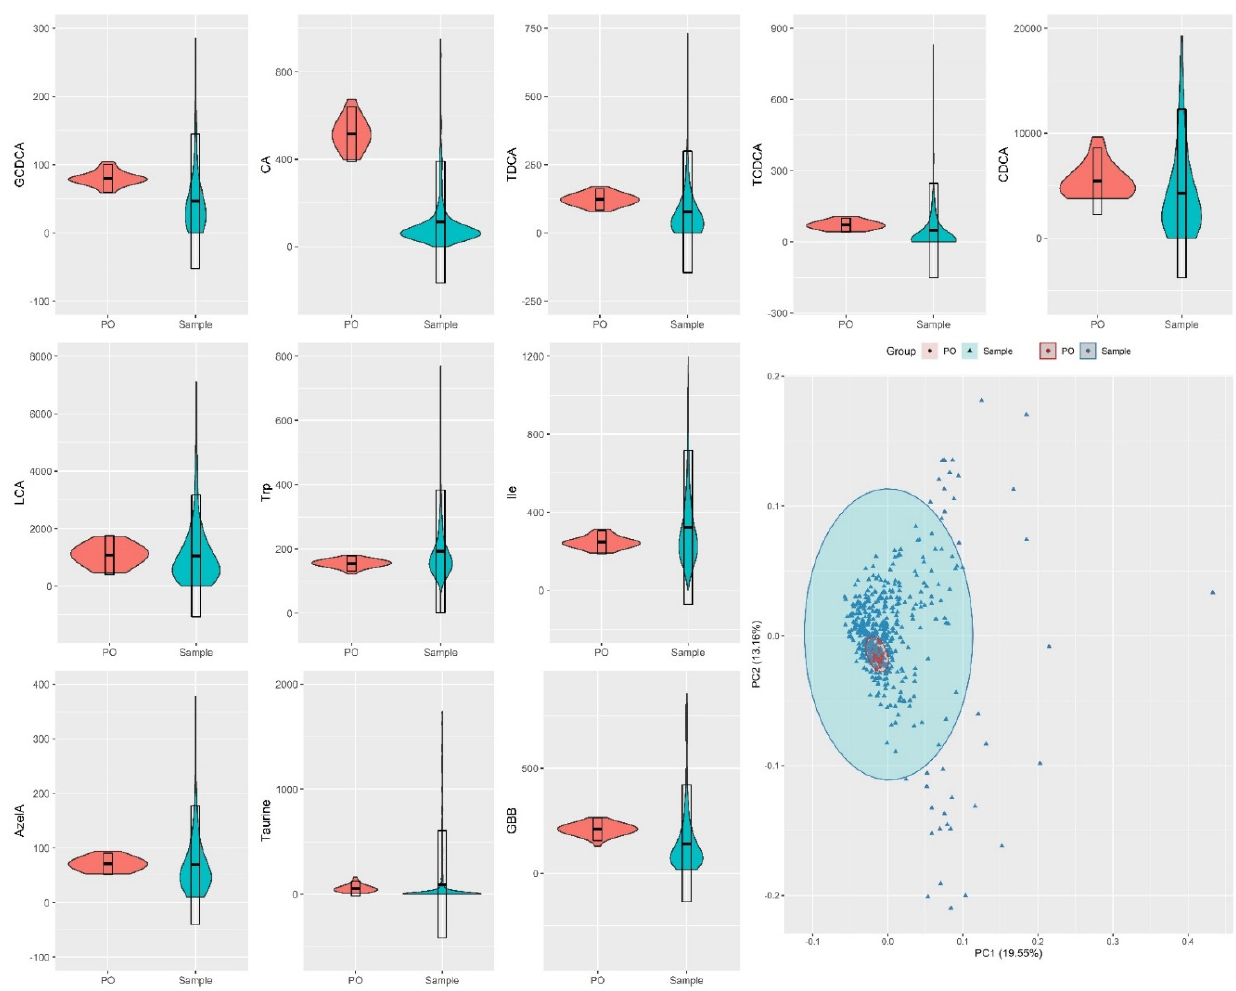
Figure 3. Violin plots for distribution of metabolite concentrations across human fecal samples representing a cohort with different degrees of liver disease (n = 475) and fecal pooled samples (PO), used as replicates (n = 36) for quality control. Bottom right: PCA scores plot for fecal metabolites in pooled samples and samples from the investigated cohort.